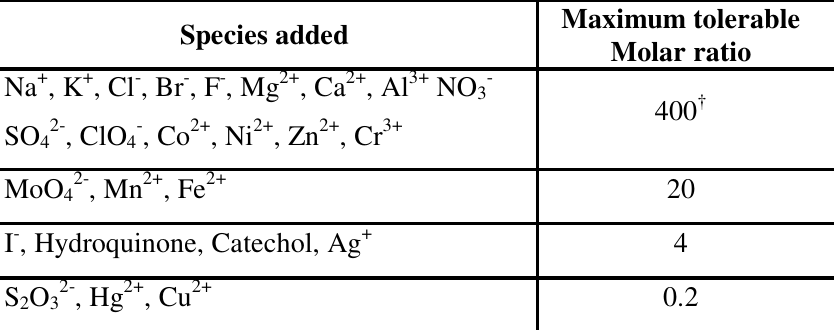
Table 1. Tolerance of different species in the determination of thiourea